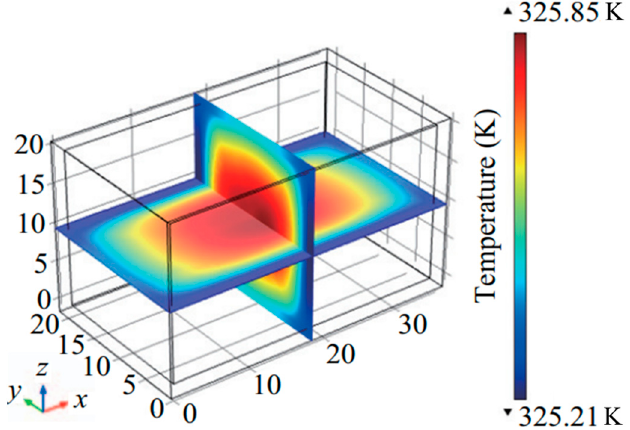
Figure 13. The temperature field distribution for an SC [129], open access.